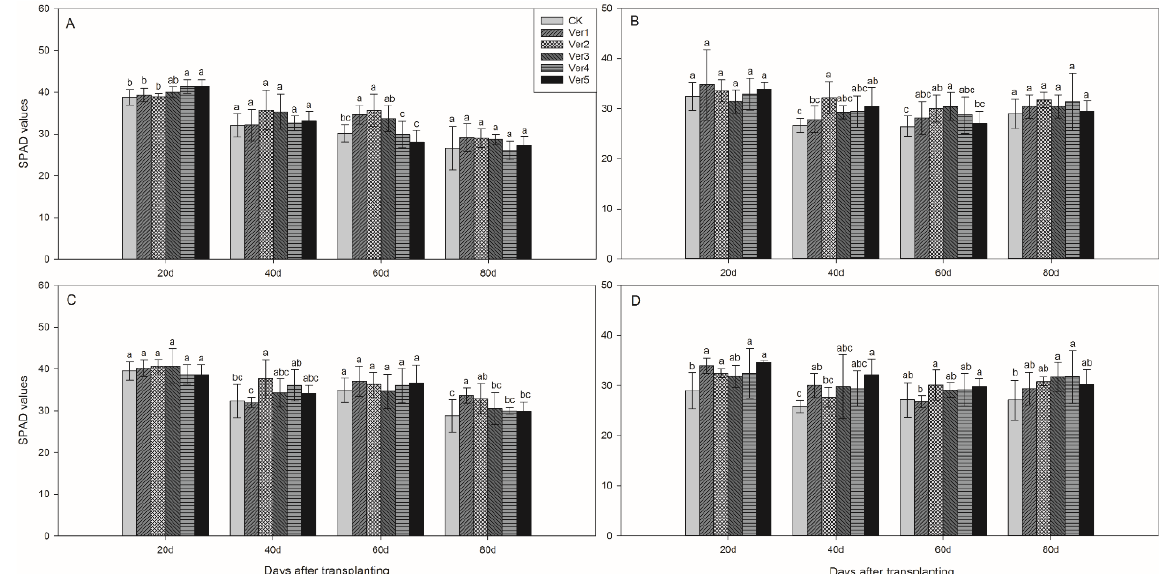
Figure 3. Effects of different vermicompost rates on chlorophyll contents (SPAD values) of fragrant rice cultivars. ( A ) Meixiangzhan-2 in early lug; ( B ) Meixiangzhan-2 in late lug; ( C ) Xiangyaxiangzhan in early lug; ( D ) Xiangyaxiangzhan in late lug. Columns with same letters are not significantly different at p < 0.05.